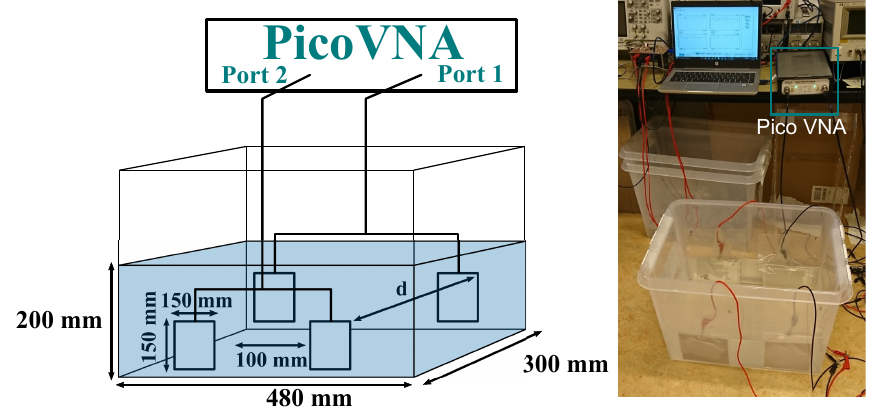
Figure 4. The measurement setup